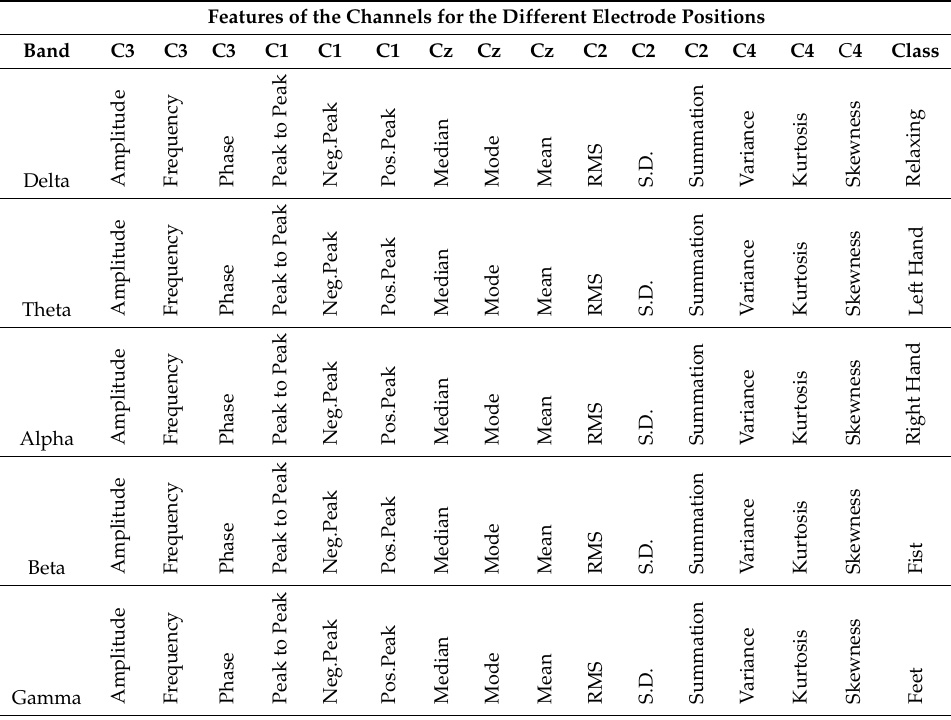
Table 3. Features of the EEG signal used to train the ML